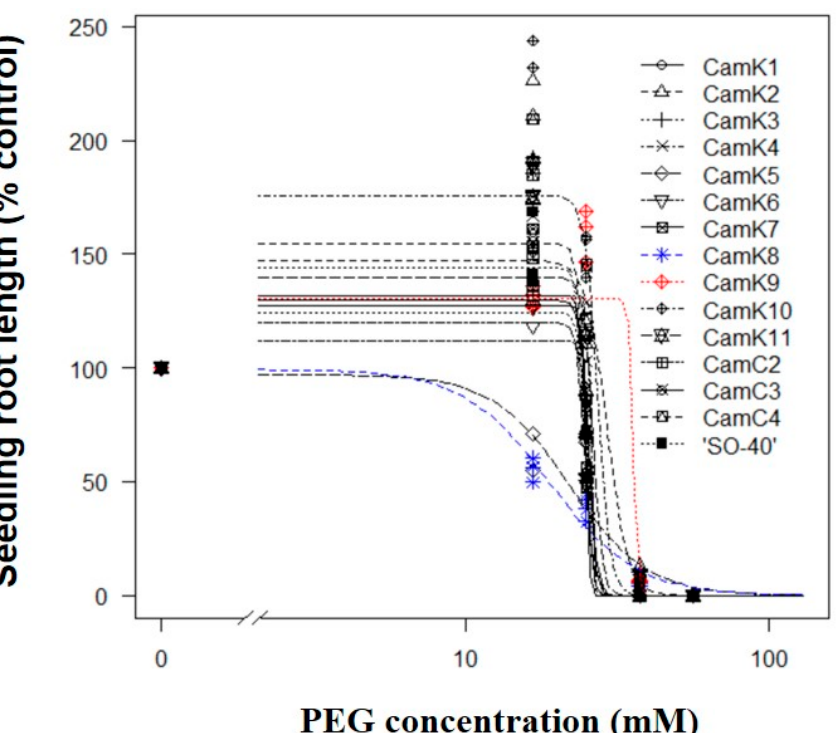
Figure 1. Dose responses in seedling root length of the fifteen camelina genotypes to various PEG solution concentrations. The blue and red dotted lines indicate the most drought–sensitive (CamK8, GR 50 = 19.0 mM) and –tolerant (CamK9, GR 50 = 34.3 mM) camelina genotypes determined based on the GR 50 values estimated using the seedling root length from the model (Equation (1)) and parameter estimates in Table S1, respectively, among the fifteen camelina genotypes.